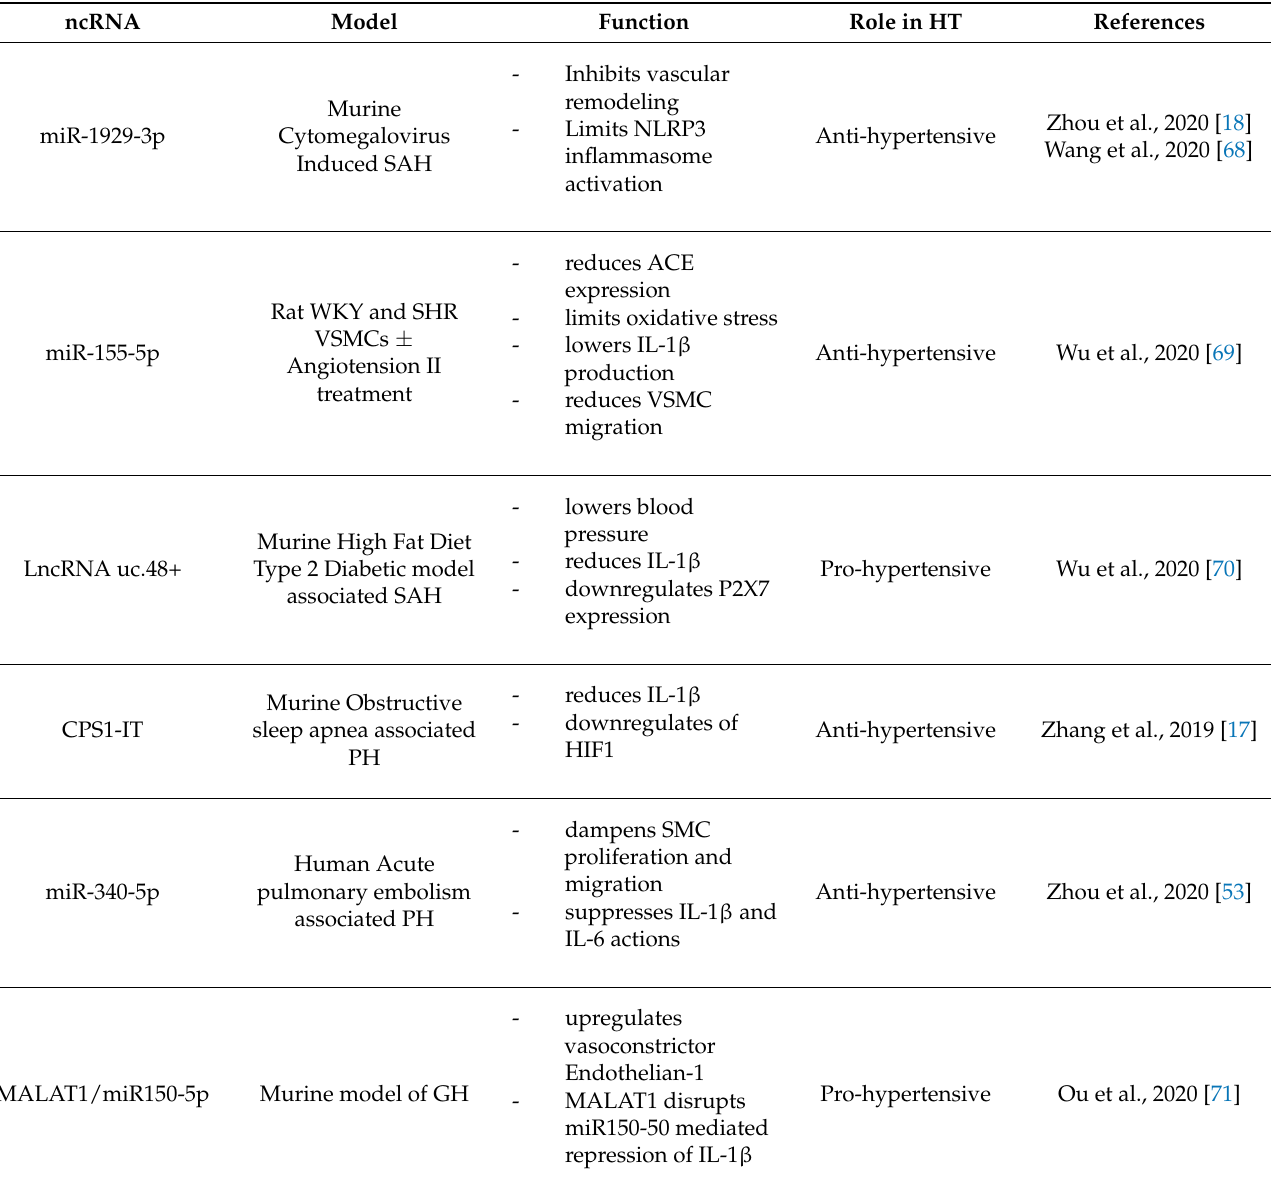
Table 1. Summary of Biological Action of ncRNA targeting the IL-1 β